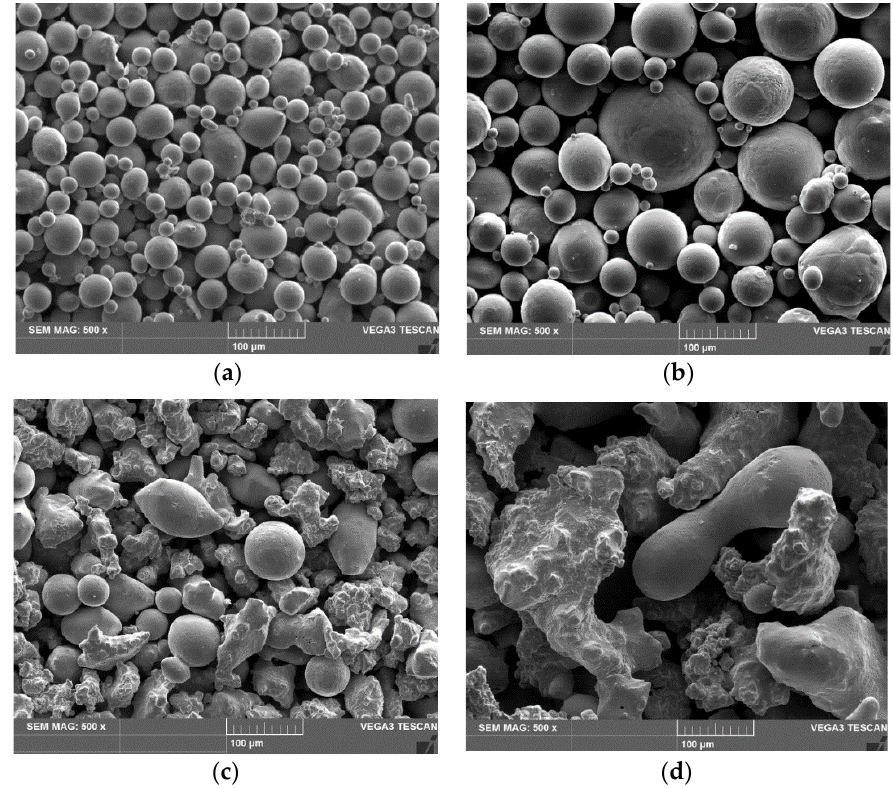
Figure 2. SEM pictures of typical morphologies of copper powders. ( a ) P-Cu-A-75; ( b ) P-Cu-A-315; ( c ) P-Cu-AW-75; ( d ) P-Cu-AW-315.